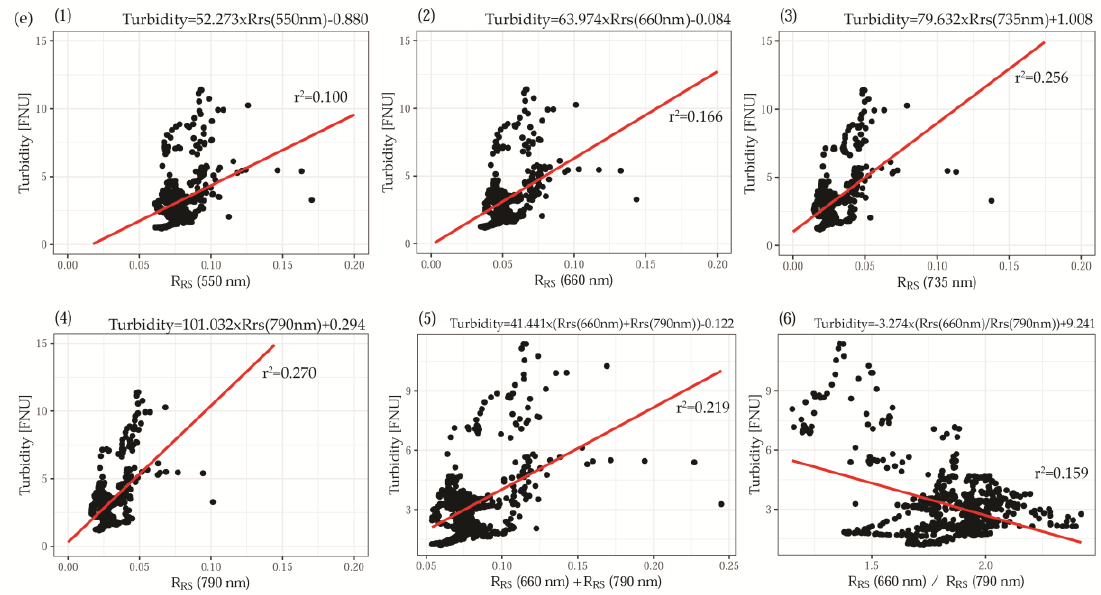
Figure 8. Scatter plots of the turbidity (FNU) versus the Rrs (550 nm, 660 nm, 735 nm, and 790 nm) for measurements performed on selected glaciers: ( a ) Ecology Glacier, ( b ) Dera Icefall, ( c ) Zalewski Glacier 1, ( d ) Zalewski Glacier 2, and ( e ) Krak Glacier.